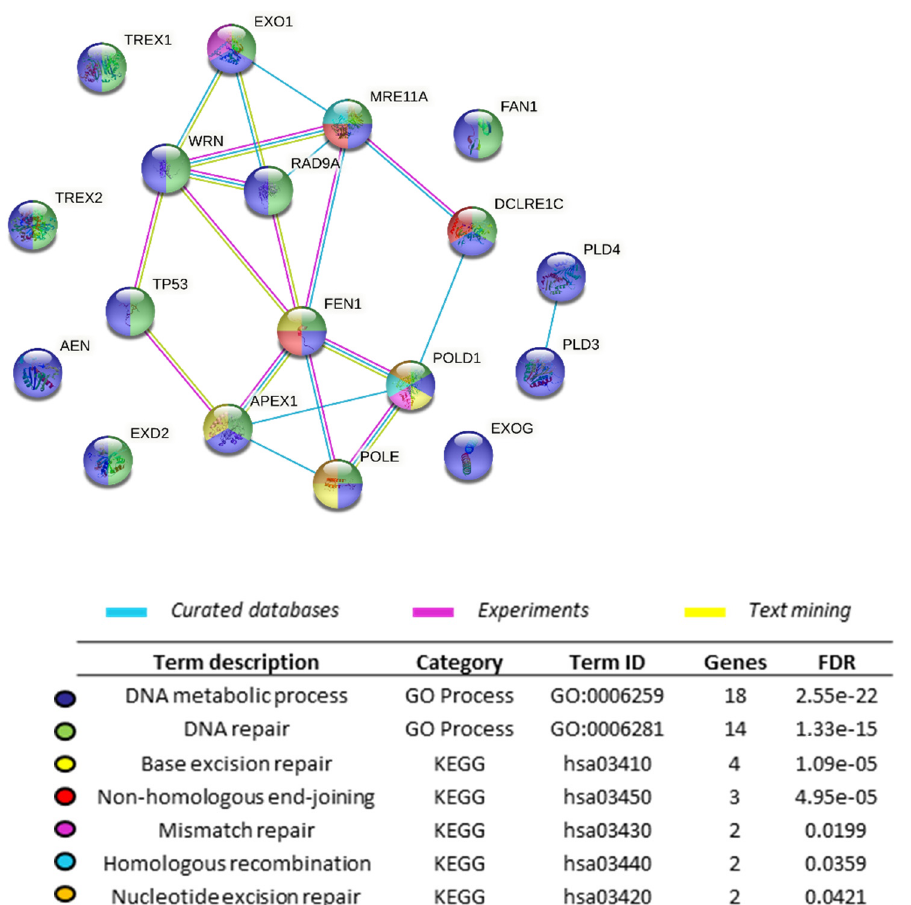
Figure 2. Exonuclease protein–protein interaction map. The interaction network of selected exonucleases was generated with STRING database v11.5 using basic settings selecting a physical subnetwork (the edges indicate that the proteins are part of a physical complex, although they may not directly interact) and medium confidence of 0.4. Proteins are represented as nodes, and lines indicate associations based on known functional interactions in humans. The network is significantly enriched in interactions (PPI enrichment p -value: 1.07e–13, FDR < 0.05). All the proteins are included in the GO-term DNA metabolic process (in blue) (GO:0006259).